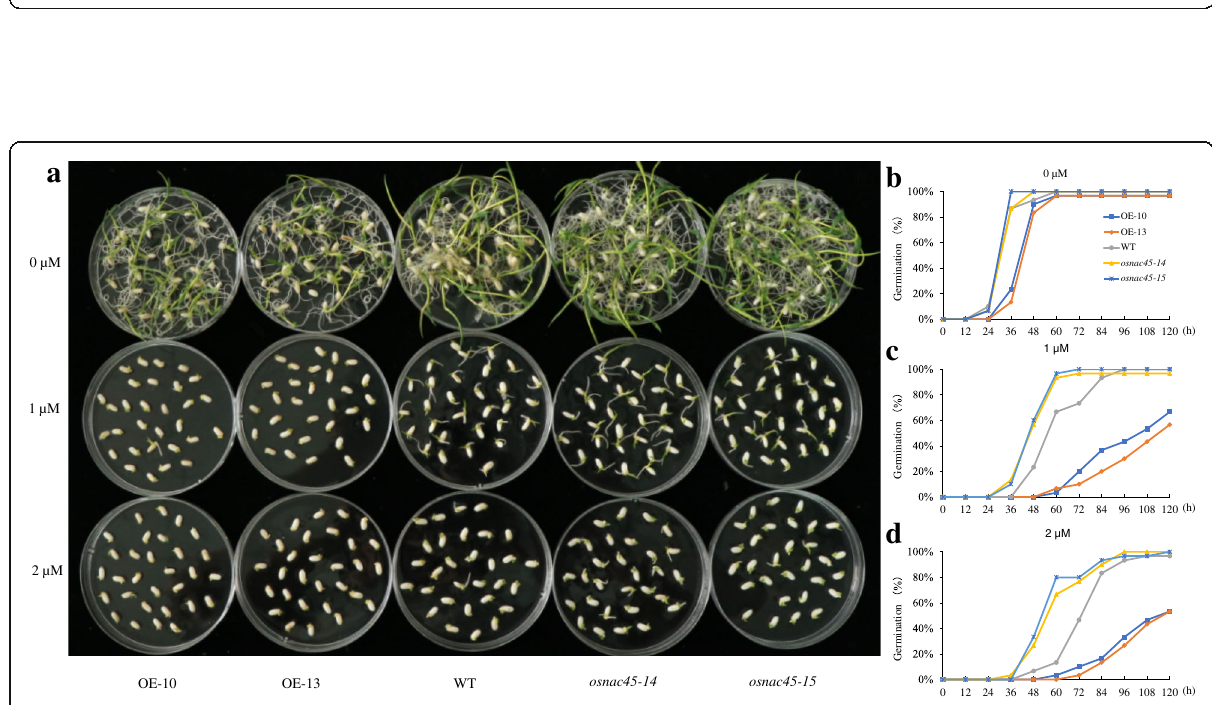
Fig. 3 Germination of OsNAC45 -knockout ( osnac45 – 14 , osnac45 – 15 ) and OsNAC45 -overexpression (OE-10, OE-13) lines under different concentrations of ABA. a Germination performance of Nipponbare, osnac45 and OsNAC45 -overexpressing seeds after 5 days on 1/2-strength MS medium containing 0, 1, and 2 μ M ABA. Germination rates of Nipponbare, osnac45 and overexpression seeds on 1/2-strength MS medium containing 0 μ M ABA ( b ), 1 μ M ABA ( c ), 2 μ M ABA ( d